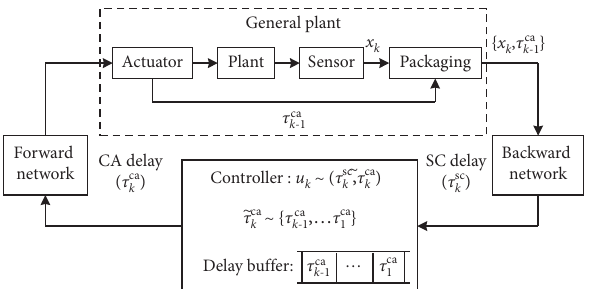
Figure 1: Refined diagram of Figure 2 with some other data.